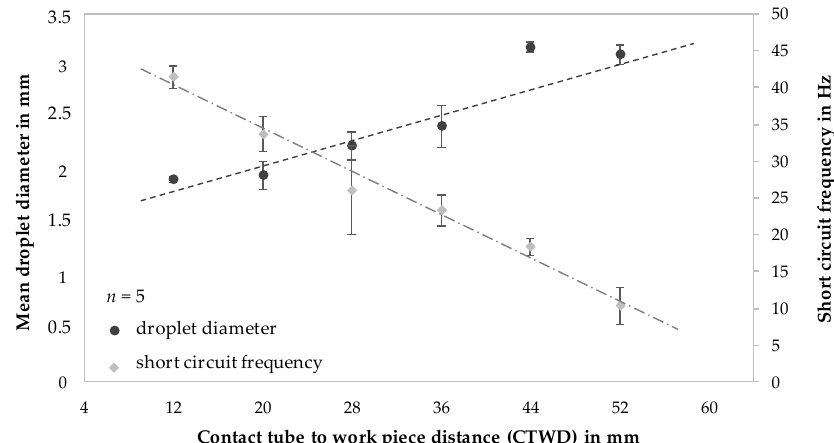
Figure 8. Correlation of mean droplet diameter and short circuit frequency with differing CTWD for U = 20 V; v wire = 5 m/min and v weld = 0.4 m/min.